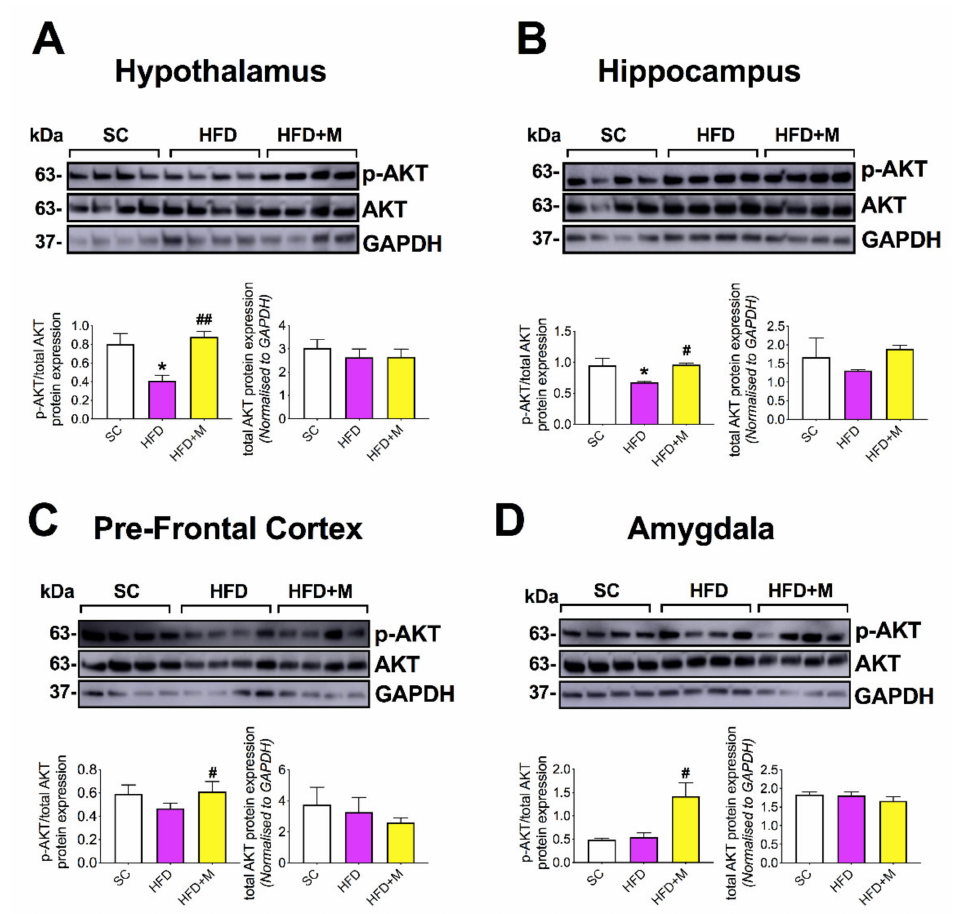
Figure 6. Effects of HFD and metformin administration on the phosphorylation of AKT at the Ser473 residue in the brain of C57BL/6 mice. Mice were grouped as SC, HFD, and HFD + M. Hypothalami, hippocampi, pre-frontal cortices, and amygdala were microdissected from the right side of the brain from all treatment groups and were used for protein extraction and subsequent Western blotting. p-AKT protein expression in ( A ) the hypothalamus, ( B ) hippocampus, ( C ) pre-frontal cortex, and ( D ) amygdala were represented in immunoblot bands for p-AKT, biological control total AKT, and loading control GAPDH. Bar graphs were also blotted for p-AKT following normalization to the biological control, total AKT (left), and a bar graph depicting total AKT protein normalized to the loading control, GAPDH (right). Quantification of blots was performed using the NIH ImageJ software. Data were given as mean ± S.E.M. * p < 0.05 vs. SC; # p < 0.05 vs. HFD group; ## p < 0.01 vs. HFD group as determined by one-way ANOVA followed by Tukey post-hoc test. n = 4 per